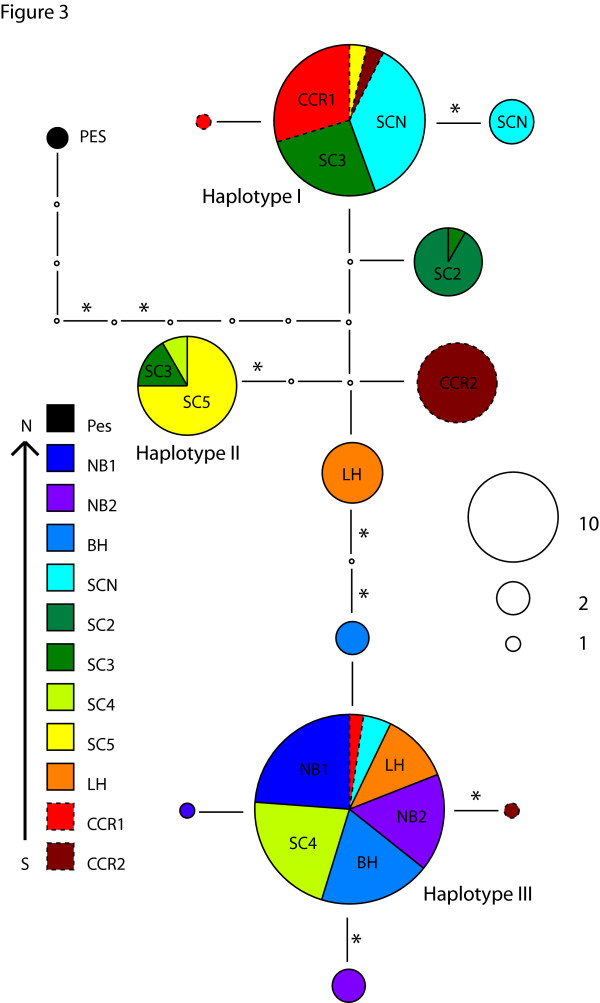
CYTB haplotype network for Santa Cruz region T. californicus. Each segment represents one nucleotide difference with non-synonymous changes indicated by an *. Size of circle indicates the number of haplotypes while the colors depict the sites from which these haplotypes come. Sites are shown on the network when more than two individuals from one site have the same haplotype. The haplotypes labeled I, II, and III are shared by three or more sites. Dashed lines surrounding some haplotypes are solely for visual clarity.